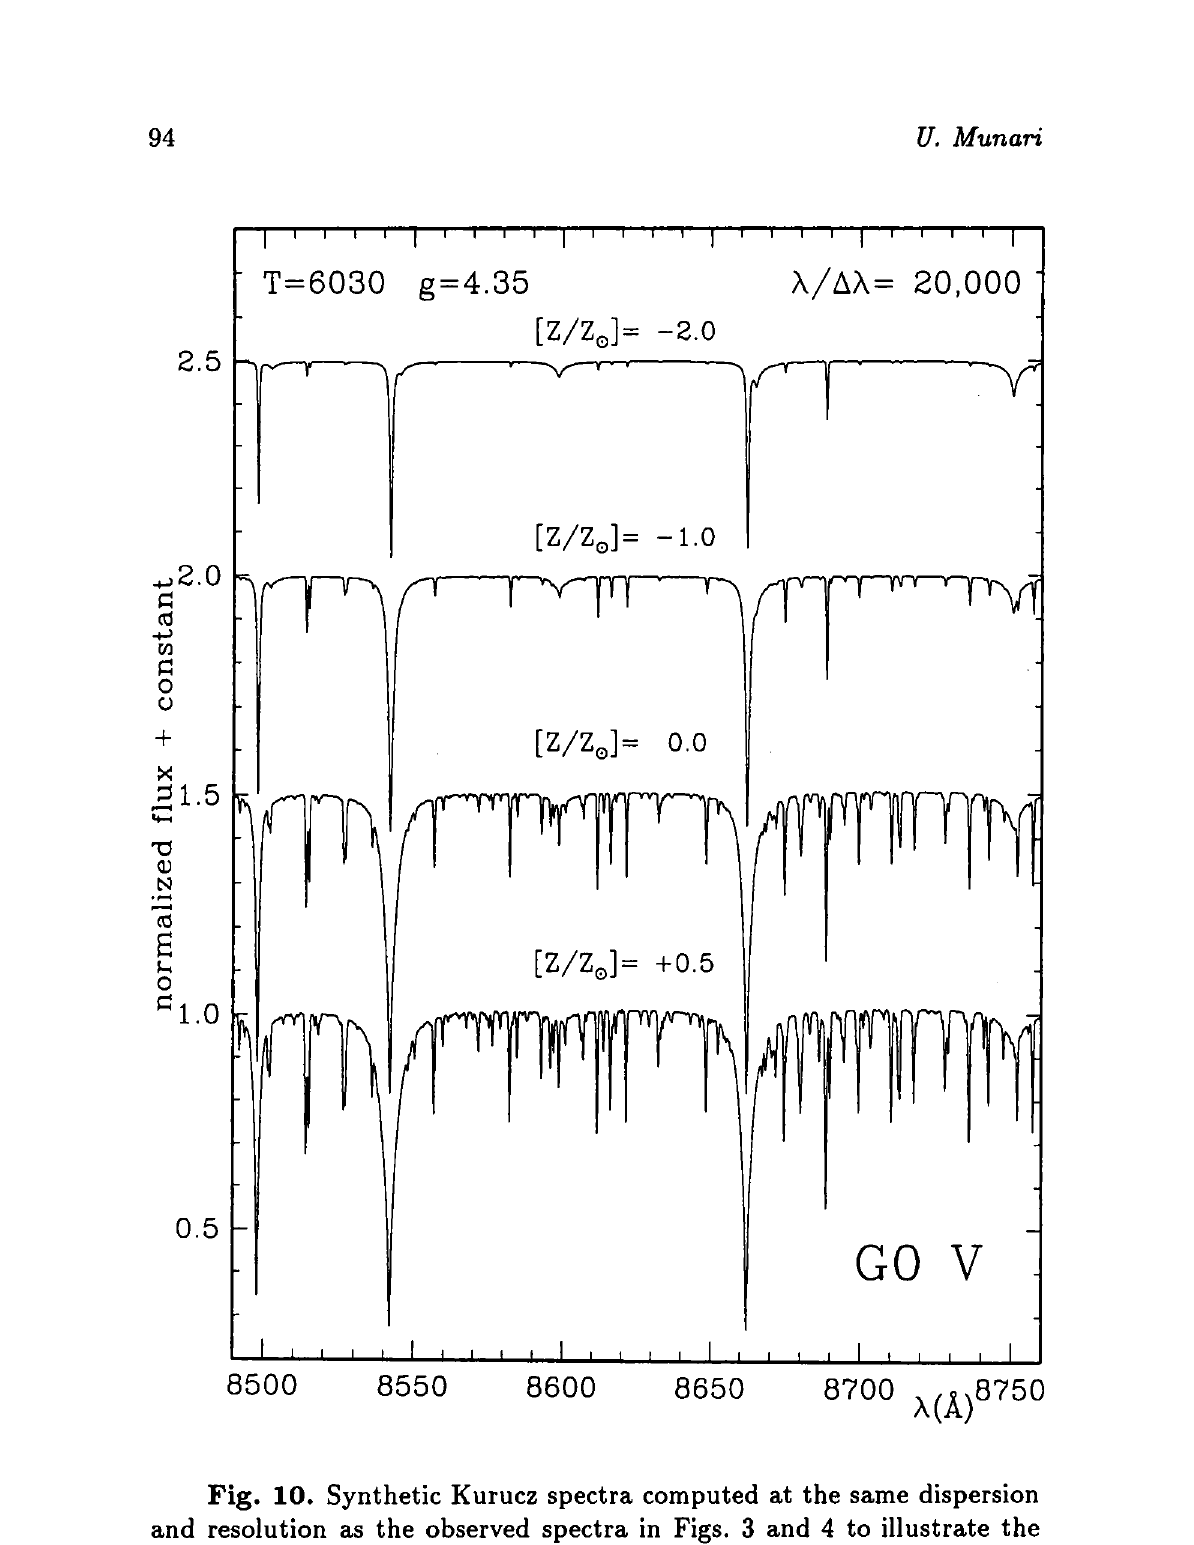
Fig. 10. Synthetic Kurucz spectra computed at the same dispersion and resolution as the observed spectra in Figs. 3 and 4 to illustrate the outstanding effects of metallicity for GOV